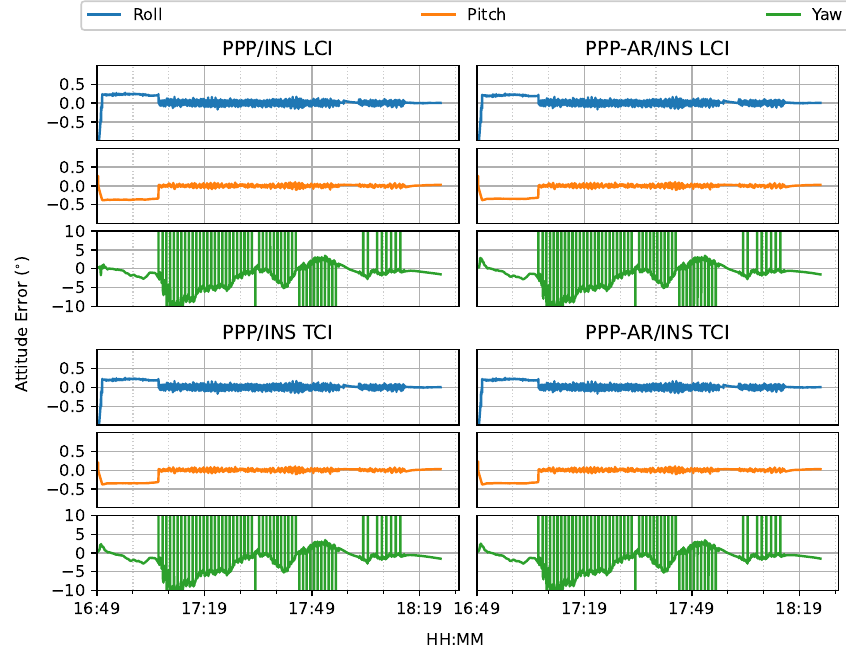
Figure 12. Attitude errors of PPP/INS train positioning test on 7 March